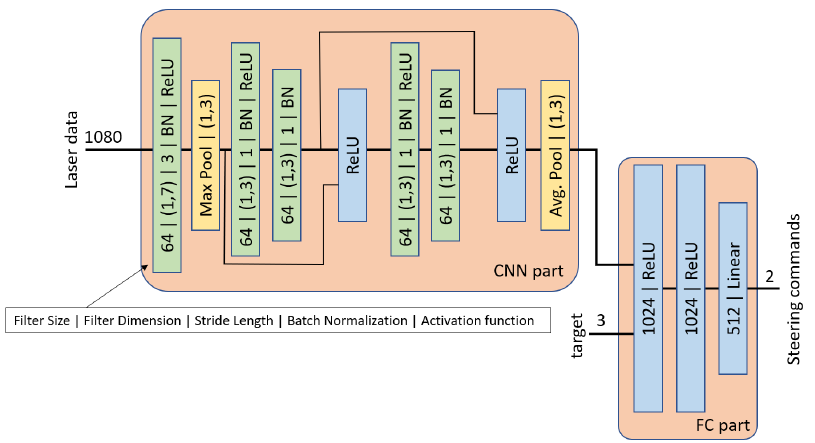
Figure 11. Structure of the CNN employed by Pfeiffer et al. [99]. Two residual building blocks provide the structure of the CNN part [106], which takes the input data (laser data) and provides the feature vector to the FC part. The FC layer of the model fuses this feature vector with the target information to obtain the translational and rotational steering commands. L1 regularization is applied to all model